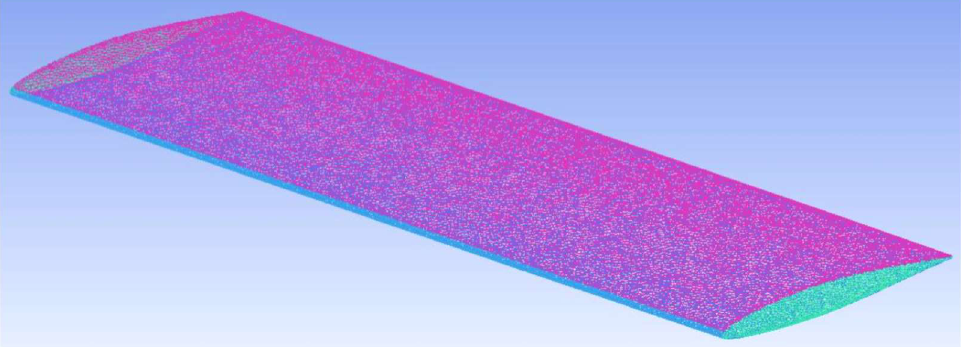
Figure 9. The grid of horizontal tail.